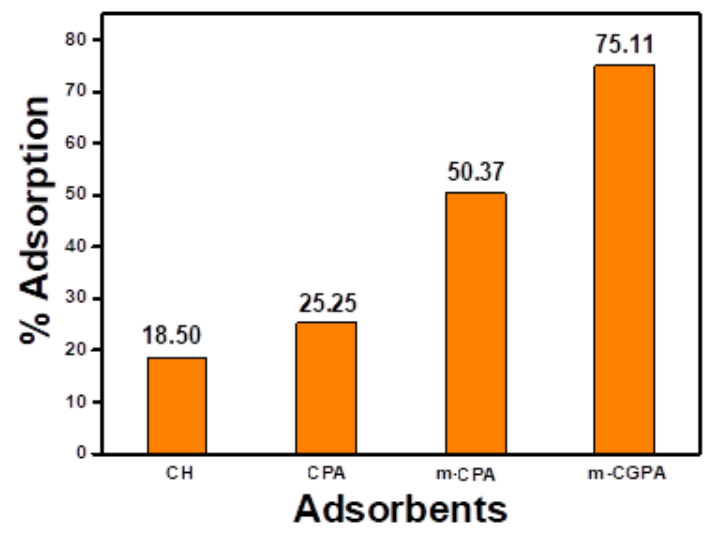
Figure 2. Comparison of adsorption efficiencies of various adsorbents.